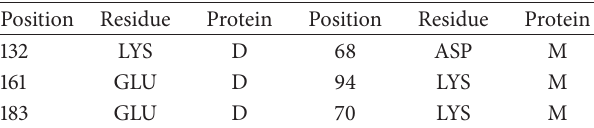
Table 3: Ionic-ionic interactions in the final simulated and refined MDM2-DHFR protein complex in Homo sapiens .